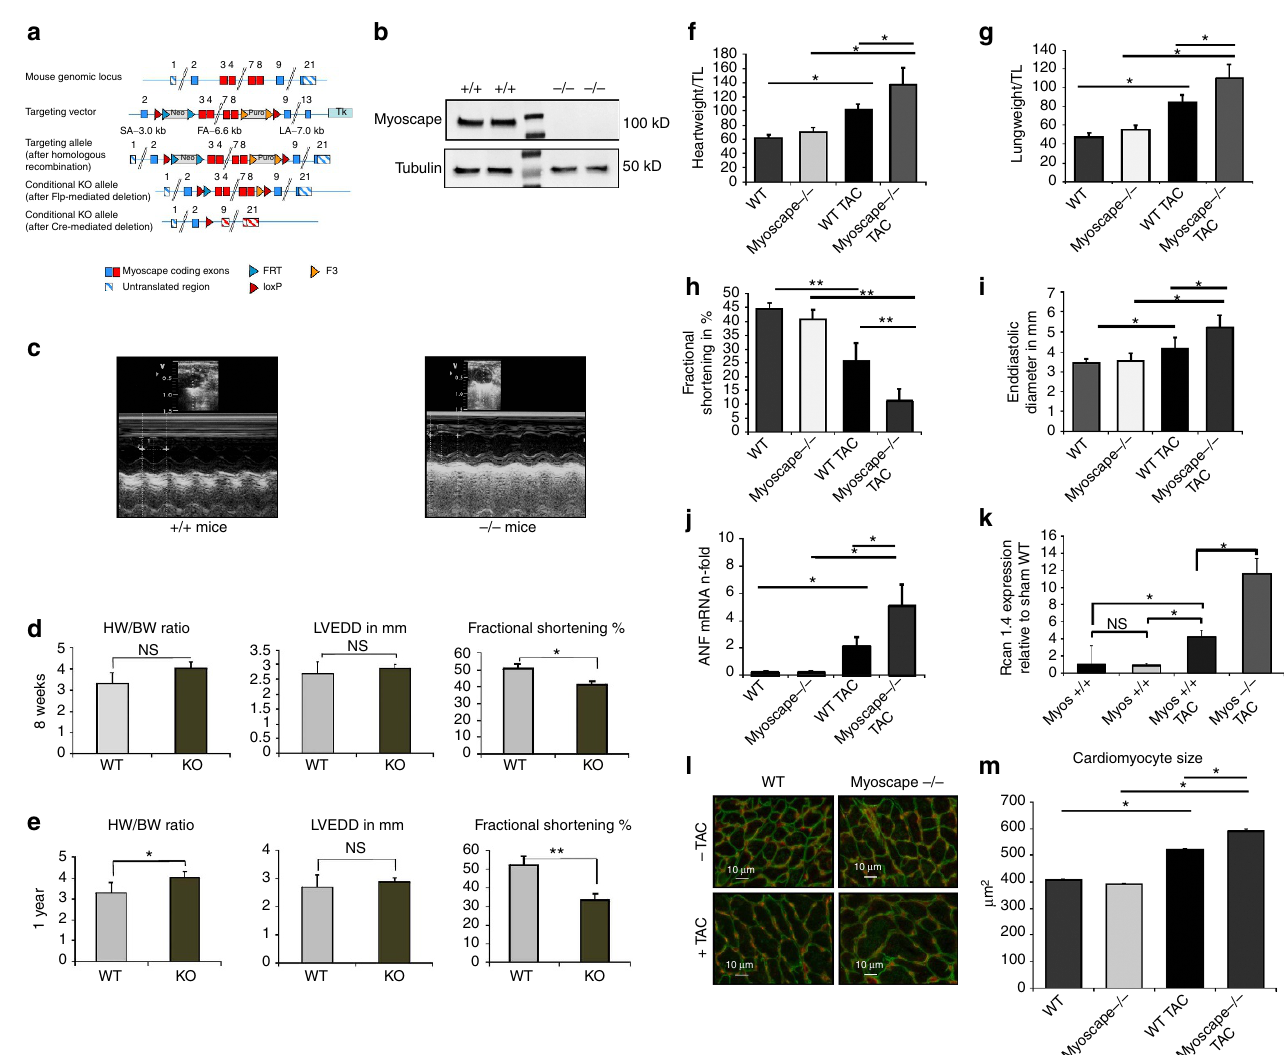
Figure 4 | Strategy and cardiovascular phenotyping of Myoscape KO mice. ( a ) Schematic representation of the knockout strategy resulting in a constitutive knockout after loxP-Cre-mediated deletion of exons 3–8. ( b ) Western blot analysis confirming that Myoscape (cid:2) / (cid:2) mice do not express detectable Myoscape protein at the expected size of 105kD. The mid-lane represents marker protein. ( c ) Representative echocardiographic recordings by a blinded observer from Myoscape þ / þ mice at the age of 6–8 weeks and from Myoscape (cid:2) / (cid:2) mice at the age of 6–8 weeks. ( d ) Statistical evaluation of morphometric (HW/BW) and echocardiographic (LVEDD and FS in %) parameters from Myoscape (cid:2) / (cid:2) or þ / þ mice at the age of approx. 8 weeks and ( e ) after one year revealing progressive heart failure in the absence of severe hypertrophy. * P o 0.05; ** P o 0.01. (ANOVA) ( f ) After 4 weeks of pressure overload due to transverse aortic constriction (TAC), Myoscape knockouts showed a significant increase of heart weight to tibia length ratios compared with wild-type mice (136.6 ± 24 versus 101.1 ± 9; * P o 0.05 (ANOVA)). ( g ) Myoscape-null mice show higher lung weight to tibia length ratios (110 ± 15 versus 84 ± 8.5; * P o 0.05 (ANOVA)) than control littermates, indicating the presence of congestive heart failure. ( h ) In echocardiographic measurements of ventricular fractional shortening, Myoscape knockouts show significantly exacerbated contractile impairment (11.2 ± 6.4 versus 25.6 ± 4.4; * P o 0.05 (ANOVA), further underlined by significant ventricular enlargement. ( i ) Absence of Myoscape leads to a nduction of the hypertrophy- associated fetal gene programme as assessed by qPCR analysis of significantly increasd ANF levels and a strong induction of Rcan 1.4 levels as compared with wild-type animals ( j , k ), and also leads to a more pronounced increase of cardiomyocyte cell size after transverse aortic constriction ( l , m ). (592 m m 2 ± 6.3 s.e.m. versus 519 m m 2 ± 5.1 SEM; * P o 0.05 (ANOVA)). NS, not